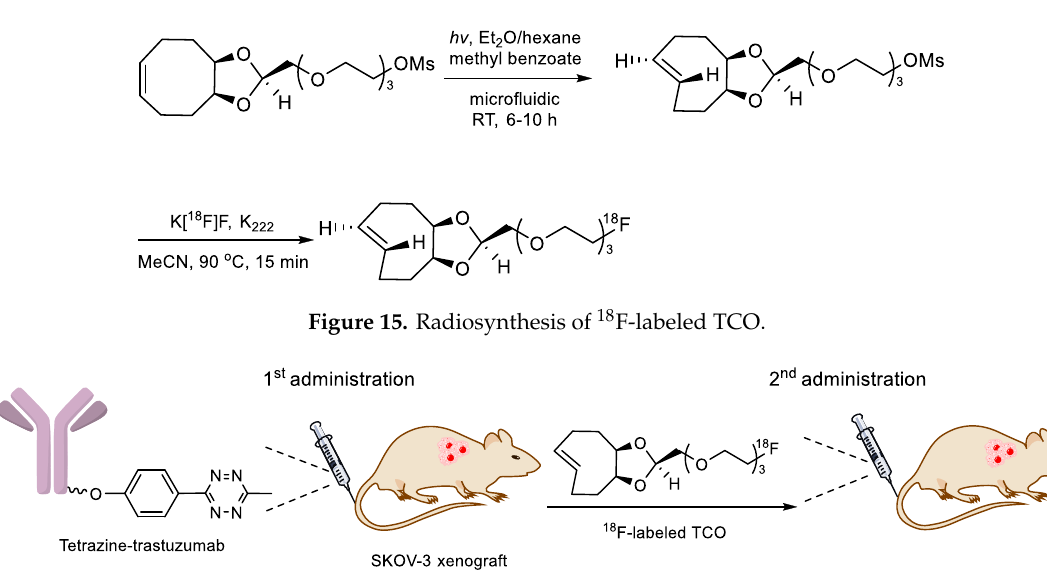
Figure 17. 11 C-labeled tetrazine tracers for in vivo IEDDA reaction, ( a ) from ref [111], ( b ) from ref [112]. The use of the TCO-tetrazine ligation in living subjects was also extended to several metal radioisotopes. Lewis et al. reported a pre-targeted strategy using a TCO-bearing huA33 antibody and